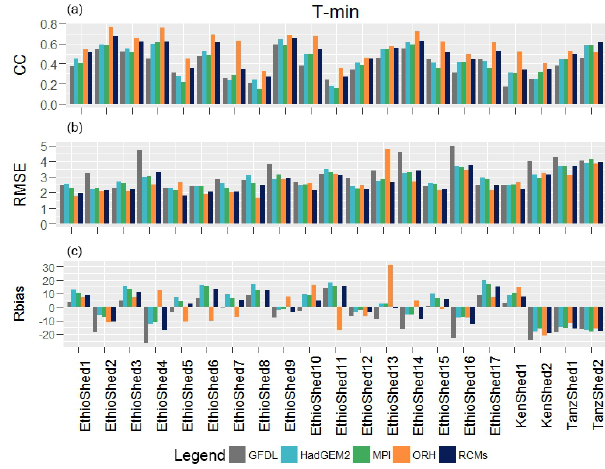
Figure 5. Statistical evaluation of daily T min retrieved from GFDL, HadGEM2, MPI, ORH, and RCMs against ground observations: CC (a) , RMSE (b) , and R bias (c) over the period of 1983–2005 for 21 validation areas of East Africa (see Table 1).